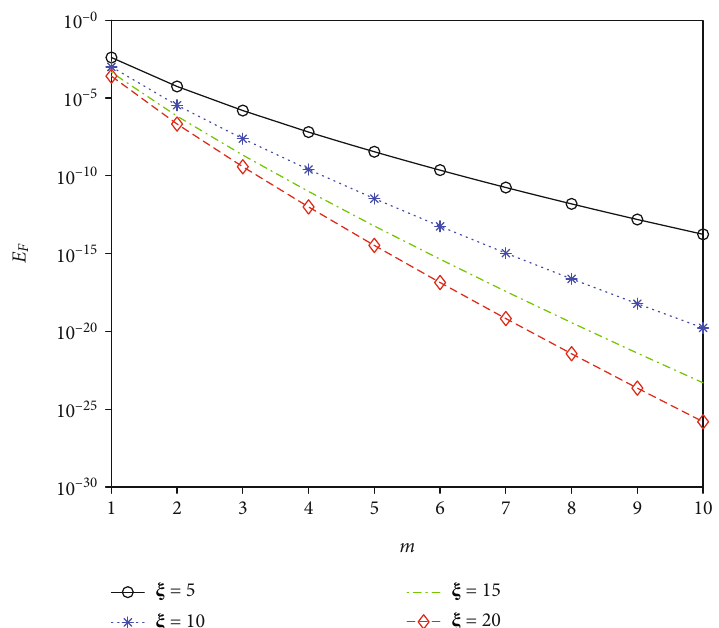
Figure 24: Variation of solution error E against increasing order ð m Þ of LSPM series approximation for di ff erent values of ξ , when n = F 0 : 5, K = 0 : 5, Pr = 10, S = 3, N = 0 : 6, Ω = 0 : 1, and He = 0 : 2 : R